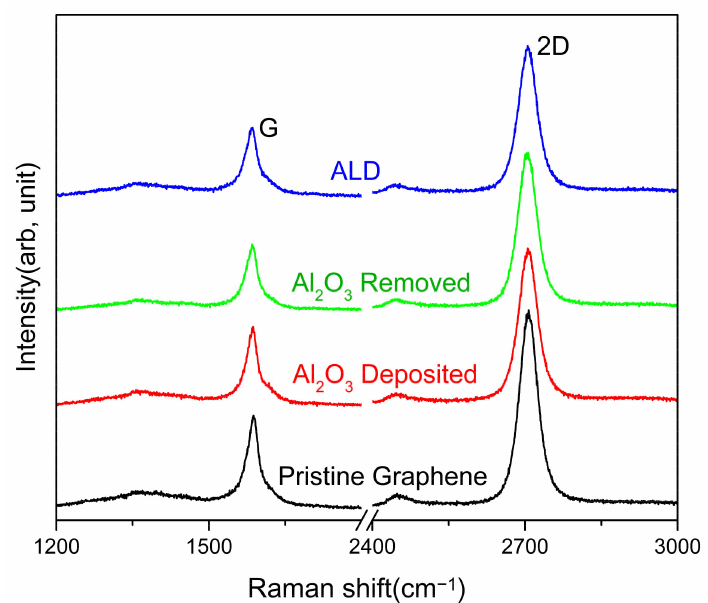
Figure 5. Raman spectra of graphene measured for different processes steps during the deposition of the dielectric film: pristine graphene (black line); 2 nm Al film deposited by e-beam evaporation on the graphene surface and naturally oxidized to alumina in air (red line); the etching of 2 nm Al 2 O 3 with solution B for 5 min at room temperature (green line); the ALD of 10 nm Al 2 O 3 (blue